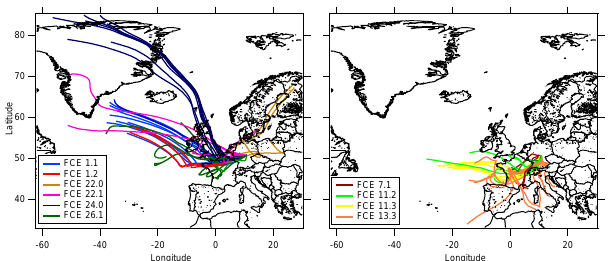
Figure 10. HYSPLIT back trajectories (96h) for air masses encoun- tered during the FCE displayed in Fig. 9. Left: FCE with low soot particle abundance; right: FCE with high soot particle abundance. Trajectory end point: Schmücke (10 ◦ 46 (cid:48) 15 (cid:48)(cid:48) E, 50 ◦ 39 (cid:48) 19 (cid:48)(cid:48) N; 500m above model ground level). Temporal difference between successive trajectories: